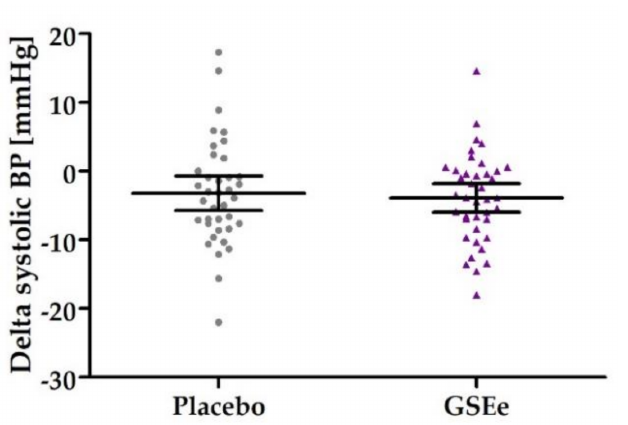
Figure 4. Primary endpoint as distribution of systolic blood pressure in placebo and GSEe. Distribu- tion is expressed as changes of systolic blood pressure in mmHg between the end of supplementation with placebo (in grey) or GSEe (in purple) and baseline measurements. Scatter diagram with mean ± 95 %